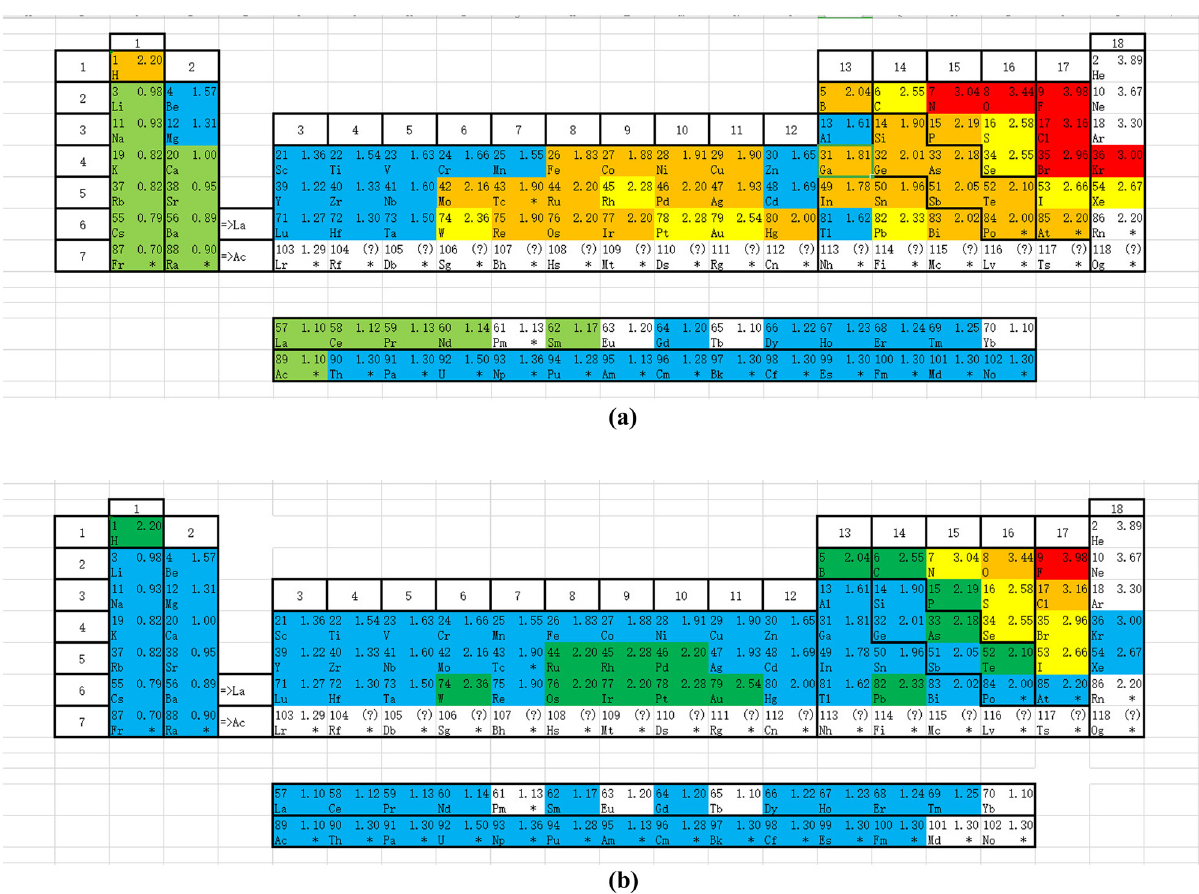
Figure 12: Five groups clustered by χ p and PR. ( a ) Five groups clustered by χ p . ( b ) Five groups clustered by